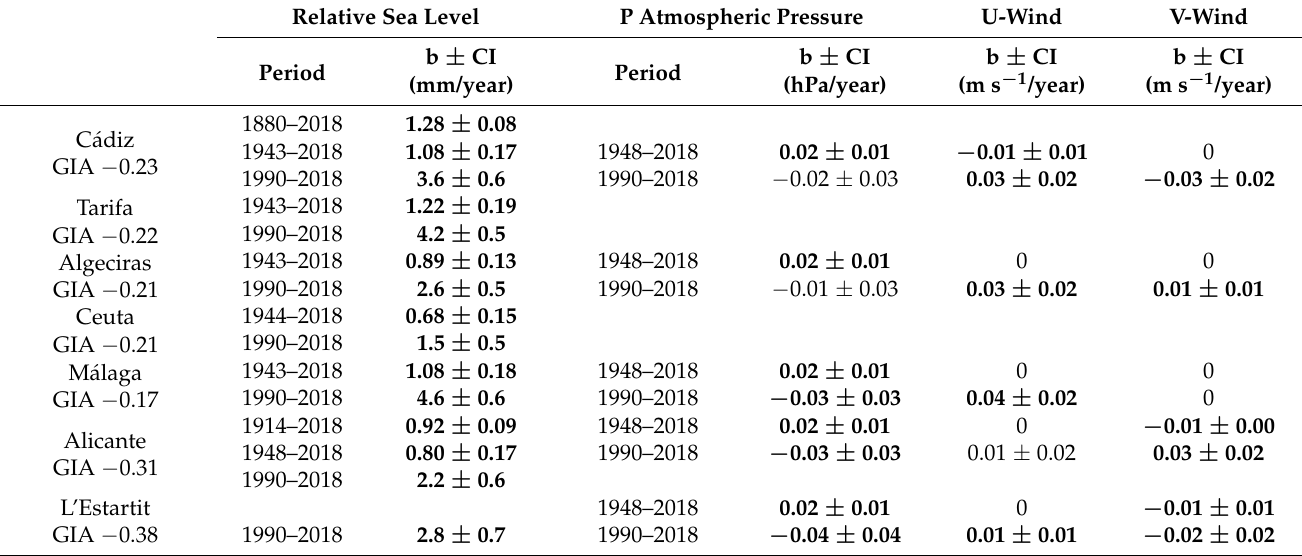
Table 2. Linear trends for the time series of de-seasoned sea level, atmospheric pressure, and the U, V components of the wind. Those trends statistically significant at the 0.05 significance level are typed in bold. Relative Sea Level P Atmospheric Pressure U-Wind V-Wind b ± CI Period